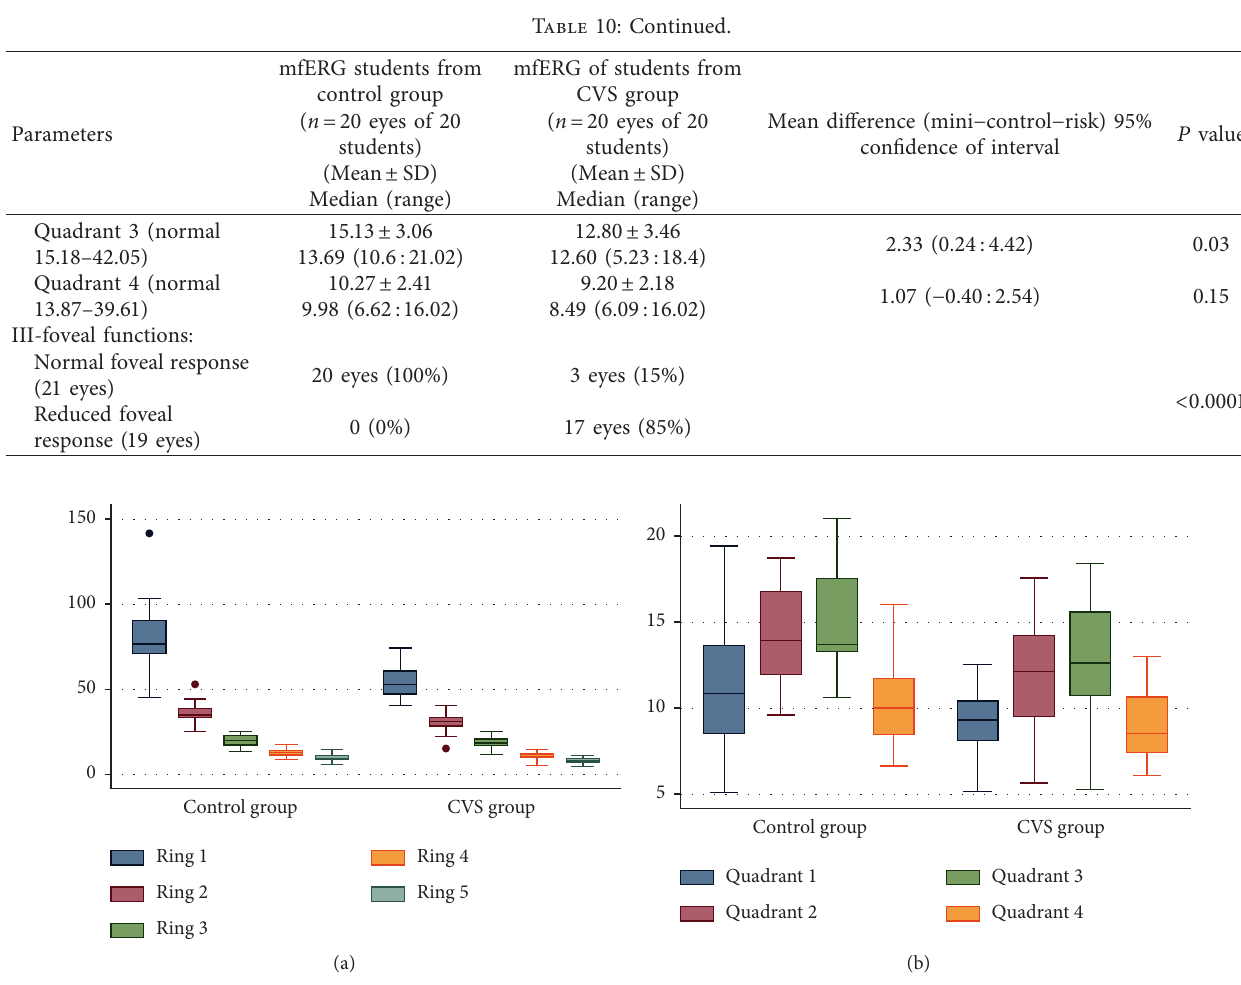
Figure 1: mfERG subgroup outcomes. (a) Plot showing the main differences in mfERG Rings P1 amplitudes between the control and the CVS groups. (b) Plot showing the main differences in mfERG Quadrants P1 amplitudes between the control and the CVS